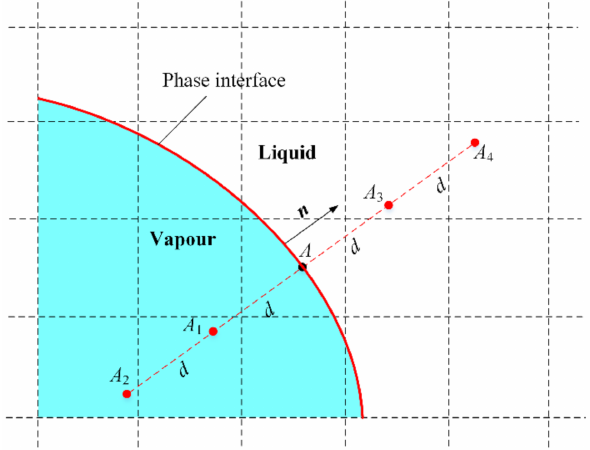
Figure 3. Schematic of the normal probe